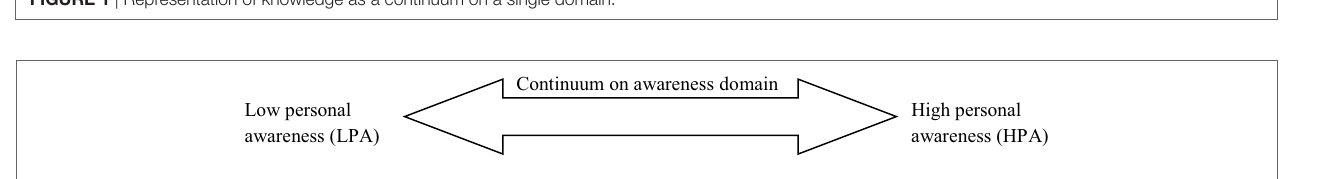
FigUre 1 | Representation of knowledge as a continuum on a single domain.